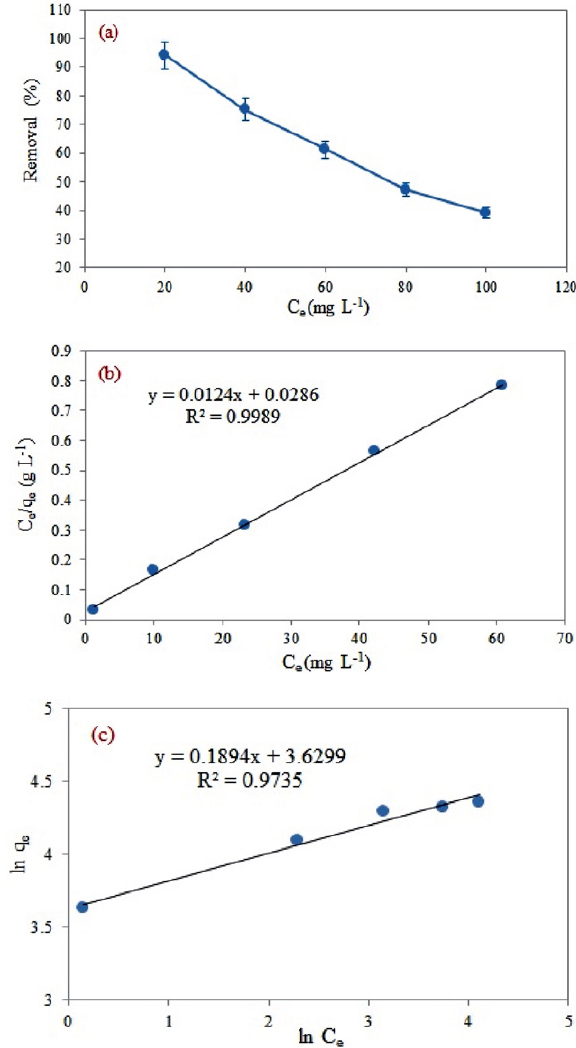
Figure 5. (a) Effect of initial concentration on MB adsorption by nanozeolite L, (b) Langmuir isotherm for MB adsorption by nano-